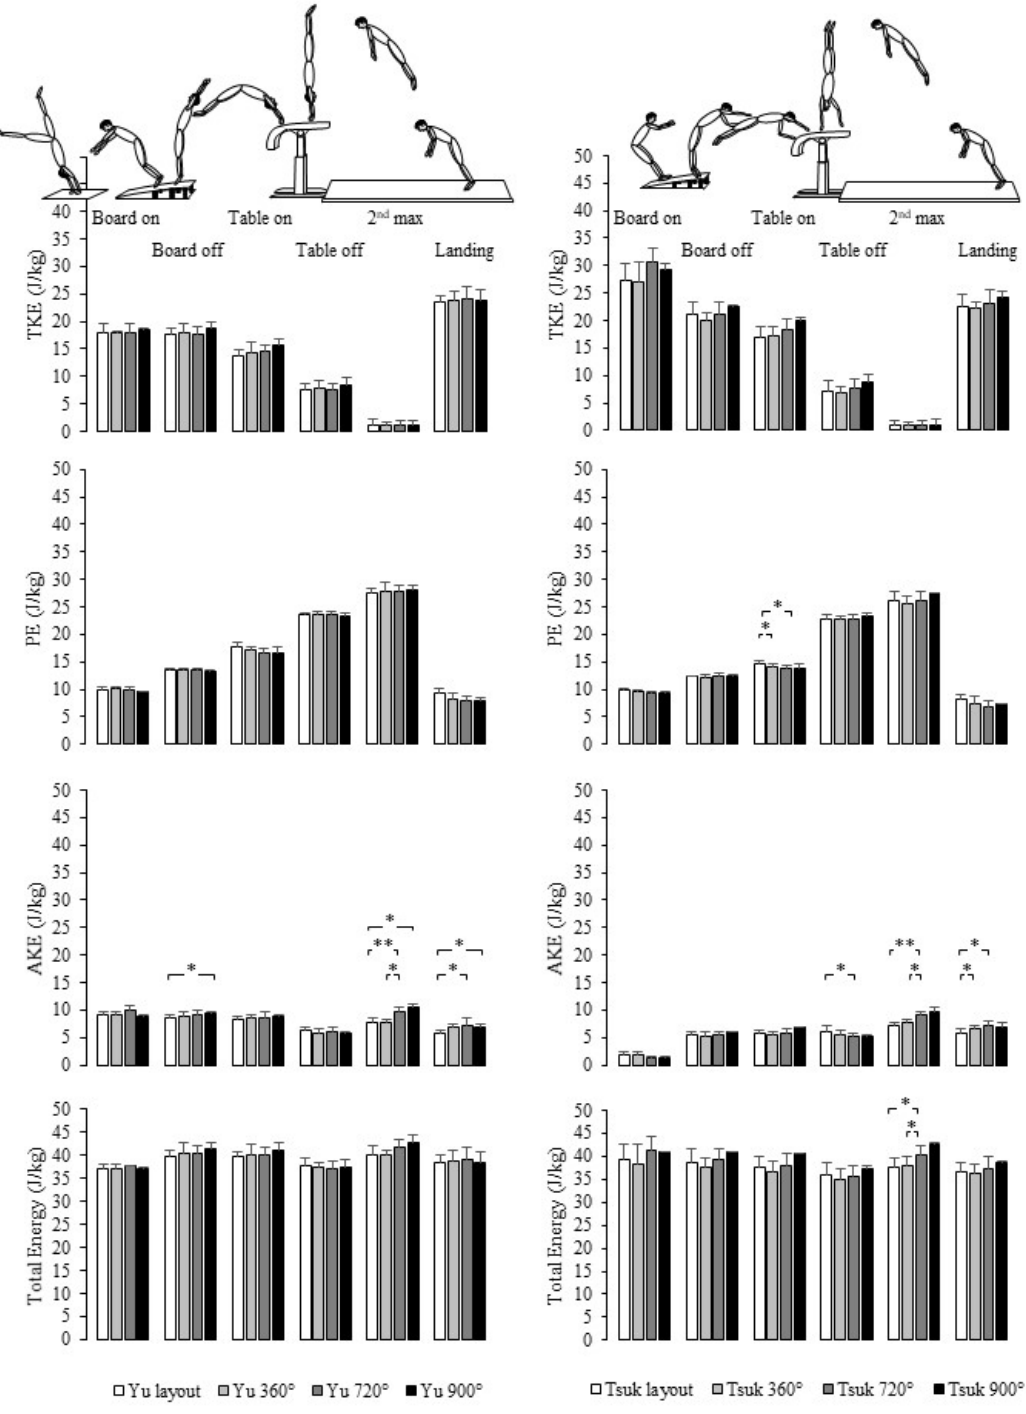
Figure 6. Comparison of various energy forms between simple and difficult Yurchenko and Tsukahara layout vaults without and with 360°, 720°, or 900° of rotation about the longitudinal axis during second flight phase (TKE: Translational kinetic energy; PE: potential energy; AKE: Angular kinetic energy; *: p < 0.05; **: p < 0.01).